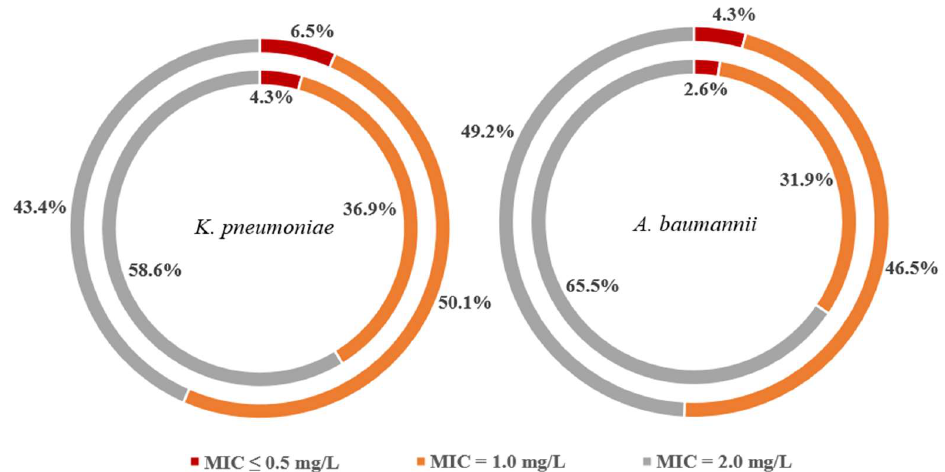
Figure 3. The distribution of minimum inhibitory concentration values of tigecycline and polymyxin B in A. baumannii and K. pneumoniae strains included in the study. The outer cycle represents the distribution of polymyxin B MICs, while the inner cycle is the distribution of tigecycline MICs. MIC, minimum inhibitory concentration. Table 1. Characteristics of patients with nosocomial pneumonia caused by carbapenem-resistant A. baumannii or K. pneumoniae